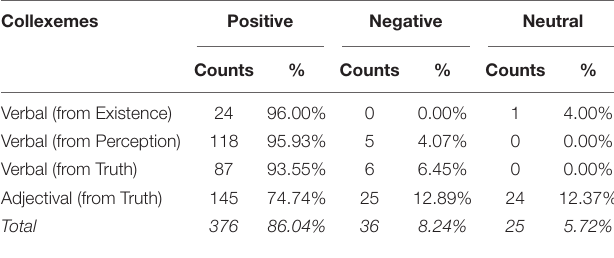
TABLE 5 | The expression of Epistemic